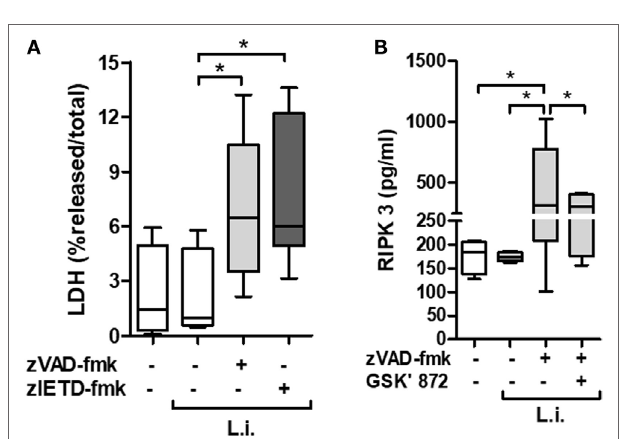
FigUre 2 | zVAD-fmk and zIETD-fmk treatment induces cell damage in Leishmania infantum -infected-human neutrophil. Human neutrophils from